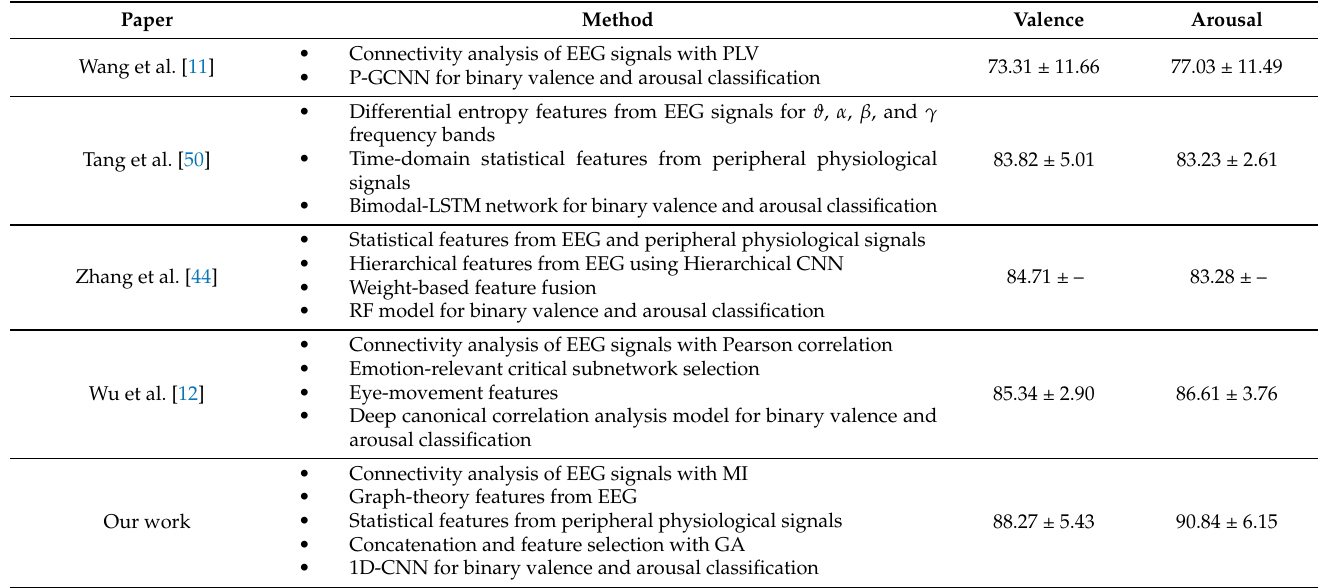
Table 4. Comparison of our accuracy results with other state-of-the-art methods using subject- dependent models. In the second column the method used for the valence and arousal classification is presented. The last two columns refer to the best accuracy results (mean±standard deviation) for the valence and arousal classification.